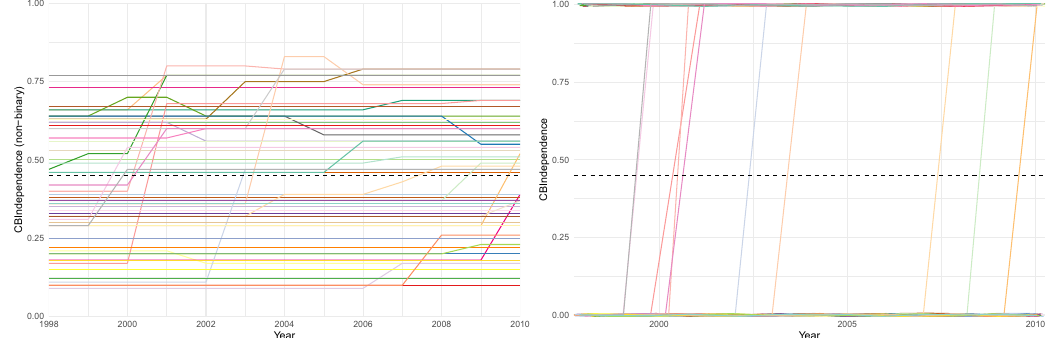
Figure 6: Trajectories of the intervention variable ( CBI ) for all included countries ( n 60 = )